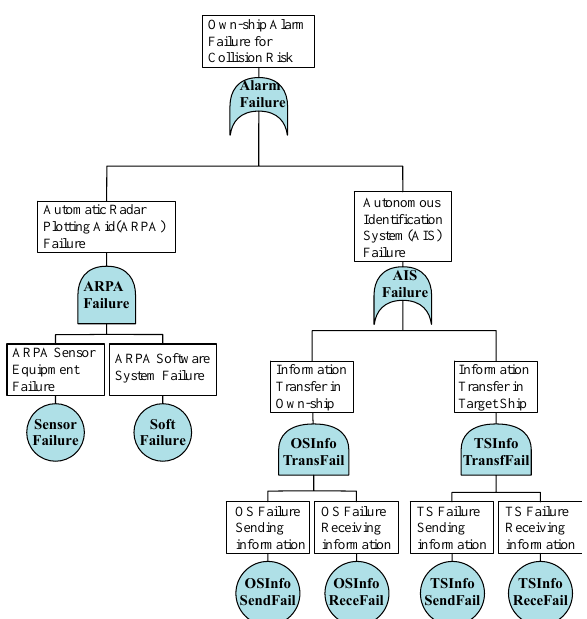
Figure 7. The FT model of OS Alarm Failure for Collision Risk (linked with PE 1 OS Collision Alarm). J. Mar. Sci. Eng. 2020 , 8 , 485